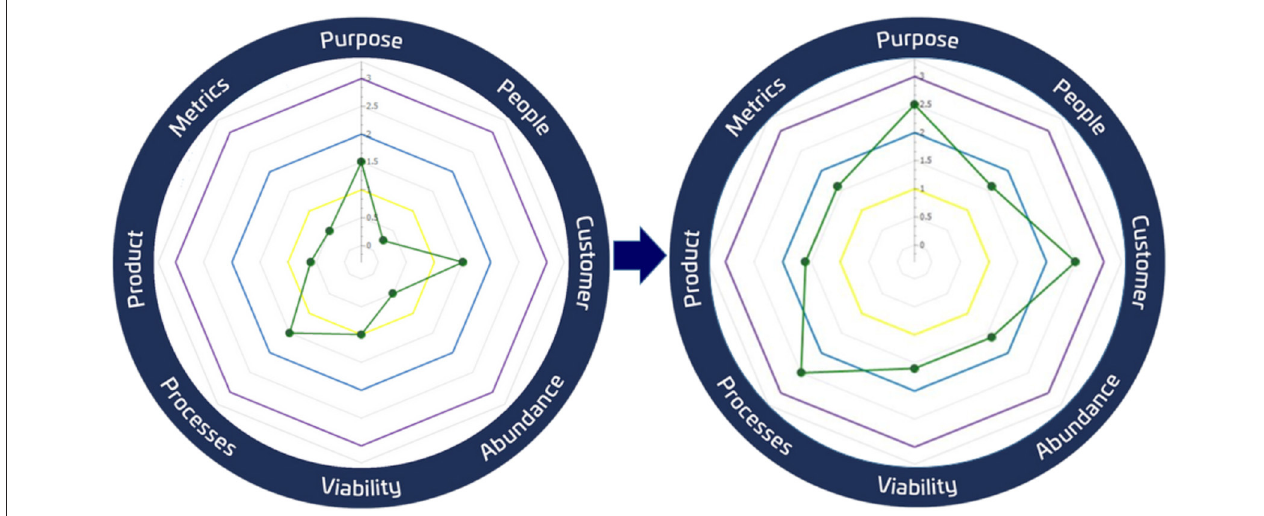
FIGURE 3 | Purpose Launchpad meta-methodology. To enhance learning, the Purpose Launchpad evaluates progress through constant assessments. In this way, the team makes real progress evolving the Purpose Launchpad eight principles over daily/weekly meetings.